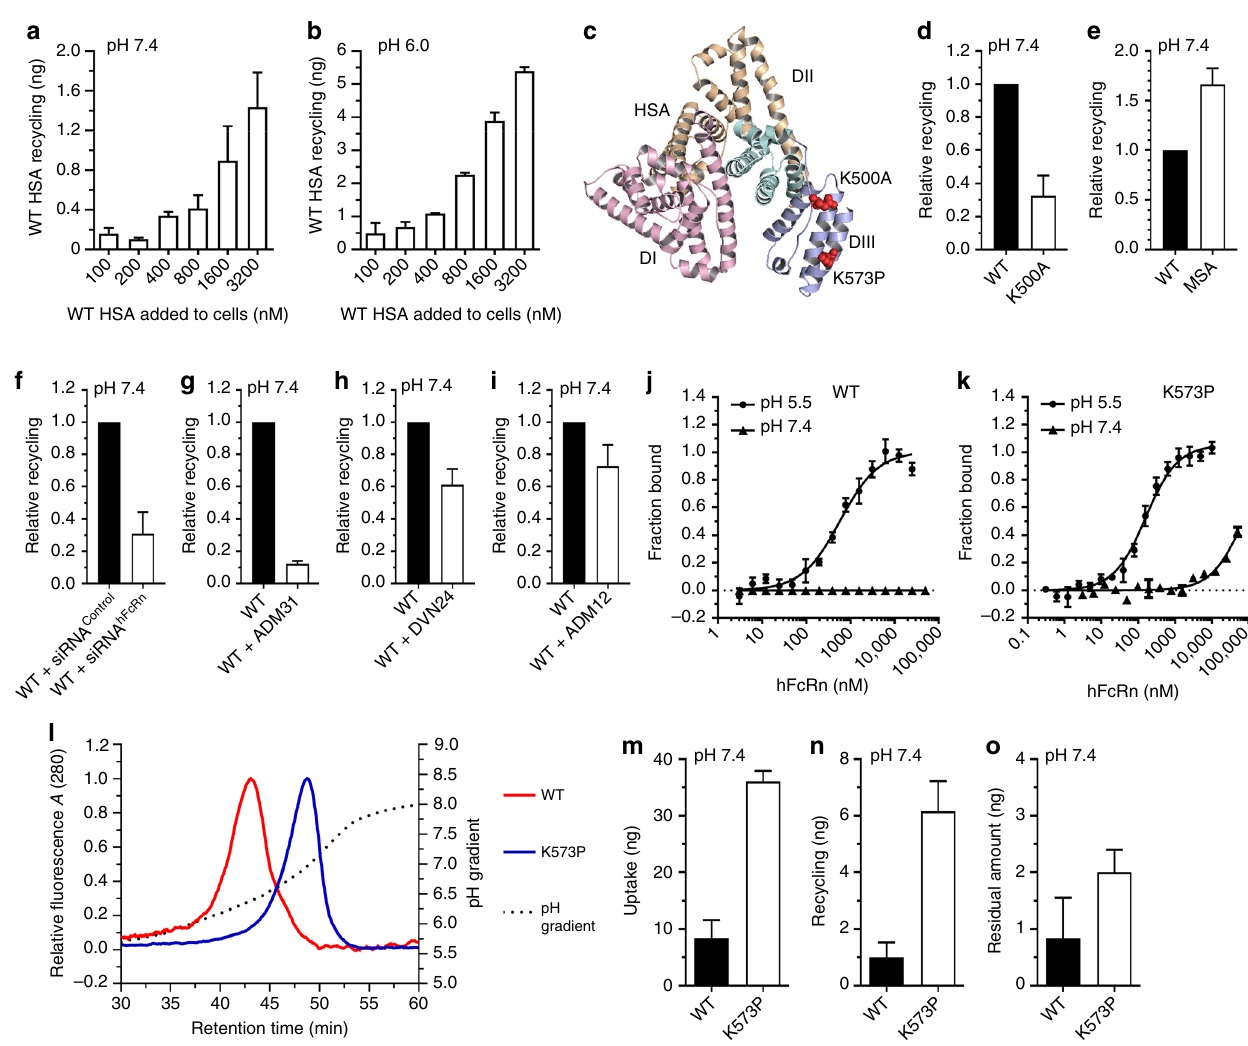
Fig. 7 HERA screening of HSA variants. Recycling of WT HSA at a pH 7.4 and b pH 6.0 after 4 h incubation with titrated HSA concentrations (100 – 3200 nM). c An illustration of the crystal structure of HSA with the amino acid residues targeted by mutagenesis (K500A and K573P) highlighted in red spheres. The fi gure was designed using the PyMOL software with the crystallographic data of HSA 70 . Histograms showing relative recycling of d WT HSA and K500A, e HSA and MSA, f WT HSA by HMEC1-FcRn cells transfected with a control or hFcRn-speci fi c siRNAs. Relative recycling of WT HSA in the absence or presence of either g ADM31 (binds the HSA binding site on hFcRn), h DVN24 (binds the IgG binding site on hFcRn) or i ADM12 (does not bind the ligand binding sites). MicroScale Thermophoresis measurements where j WT HSA-EGFP and k HSA-K573P-EGFP at a constant concentration (100 nM) were added to titrated amounts of hFcRn at pH 5.5 and 7.4. Binding data were derived from the speci fi c change in thermophoretic mobility and the ratio of normalized time-averaged (1 s) fl uorescence intensities at de fi ned time points of the MicroScale Thermophoresis traces ( − 1 and 4 s). The data from three independent experiments with three replicates are shown where error bars show ± s.d. l Analytical hFcRn af fi nity chromatography of WT and K573P. The elution pro fi les are shown as relative fl uorescence intensity and as a function of a pH gradient. m Uptake, n recycling and o residual amounts when equal amounts of WT and K573P were added at pH 7.4. The amounts of HSA variants were quanti fi ed using ELISA. The obtained data are shown as mean